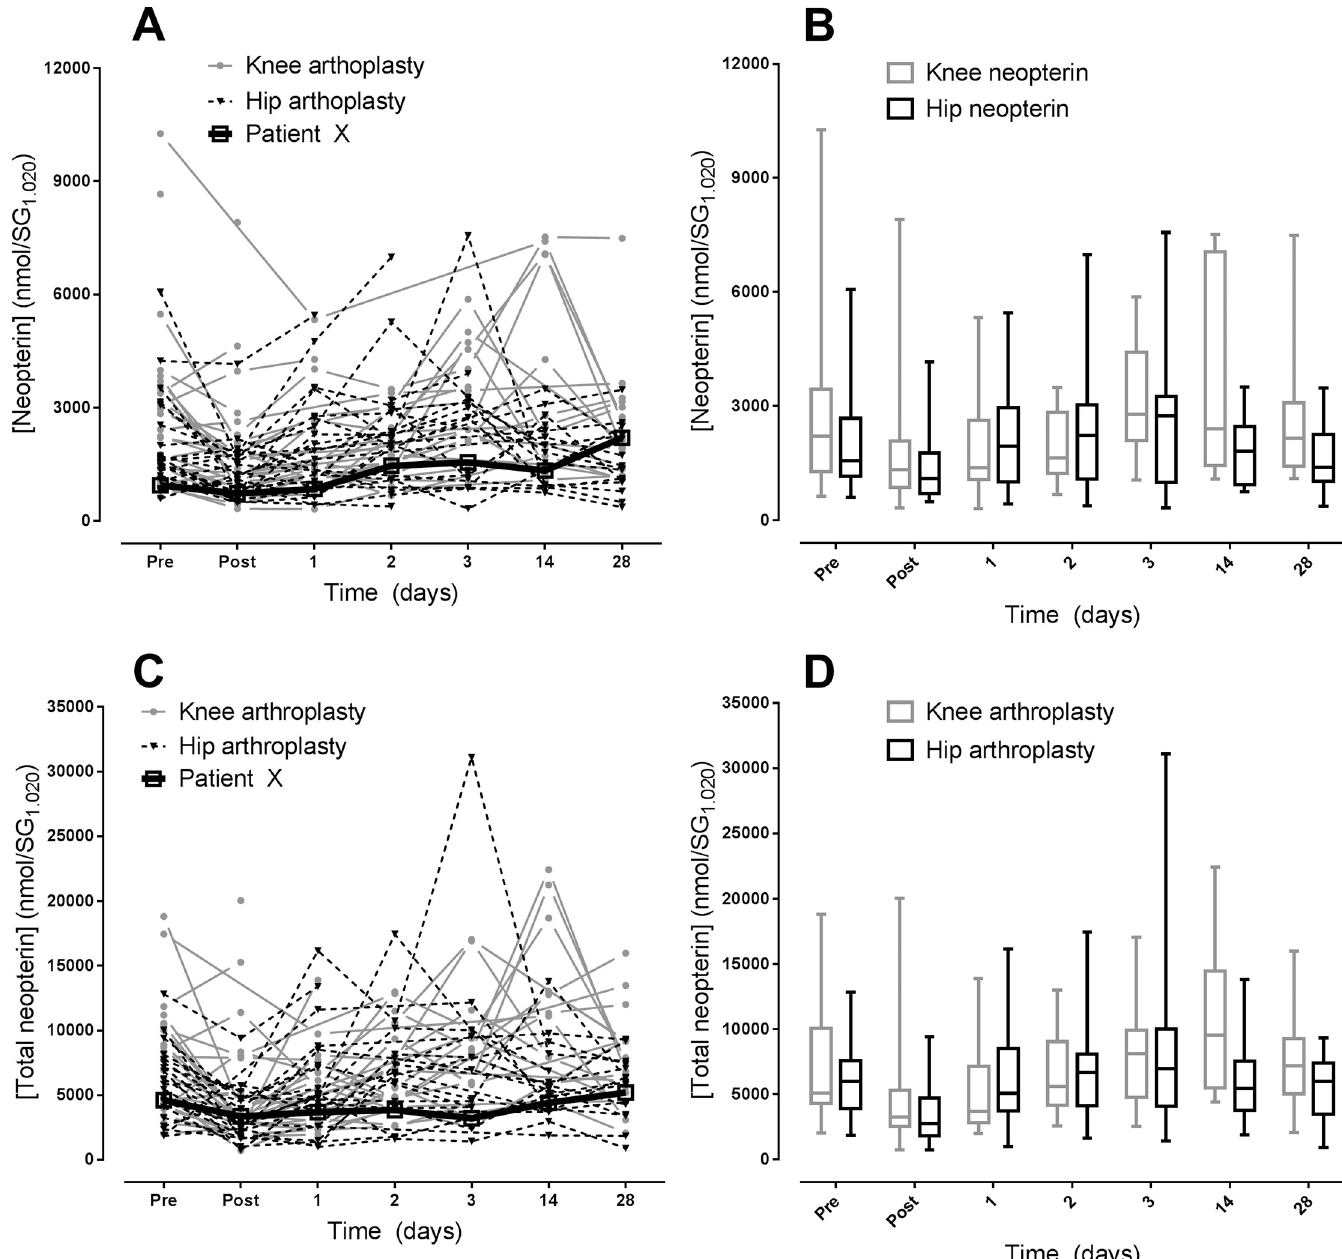
Fig 3. Individual plots (A and C) and box and whisker plots (B and D) for urinary neopterin (A and B) and total neopterin (C and D) to demonstrate inter- and intra- group variation. Each line represents a single participant. Patient X was a knee arthroplasty patient who was highly active before and shortly after surgery. Box and whisker plots depict medians, upper and lower quartiles and minimum and maximal